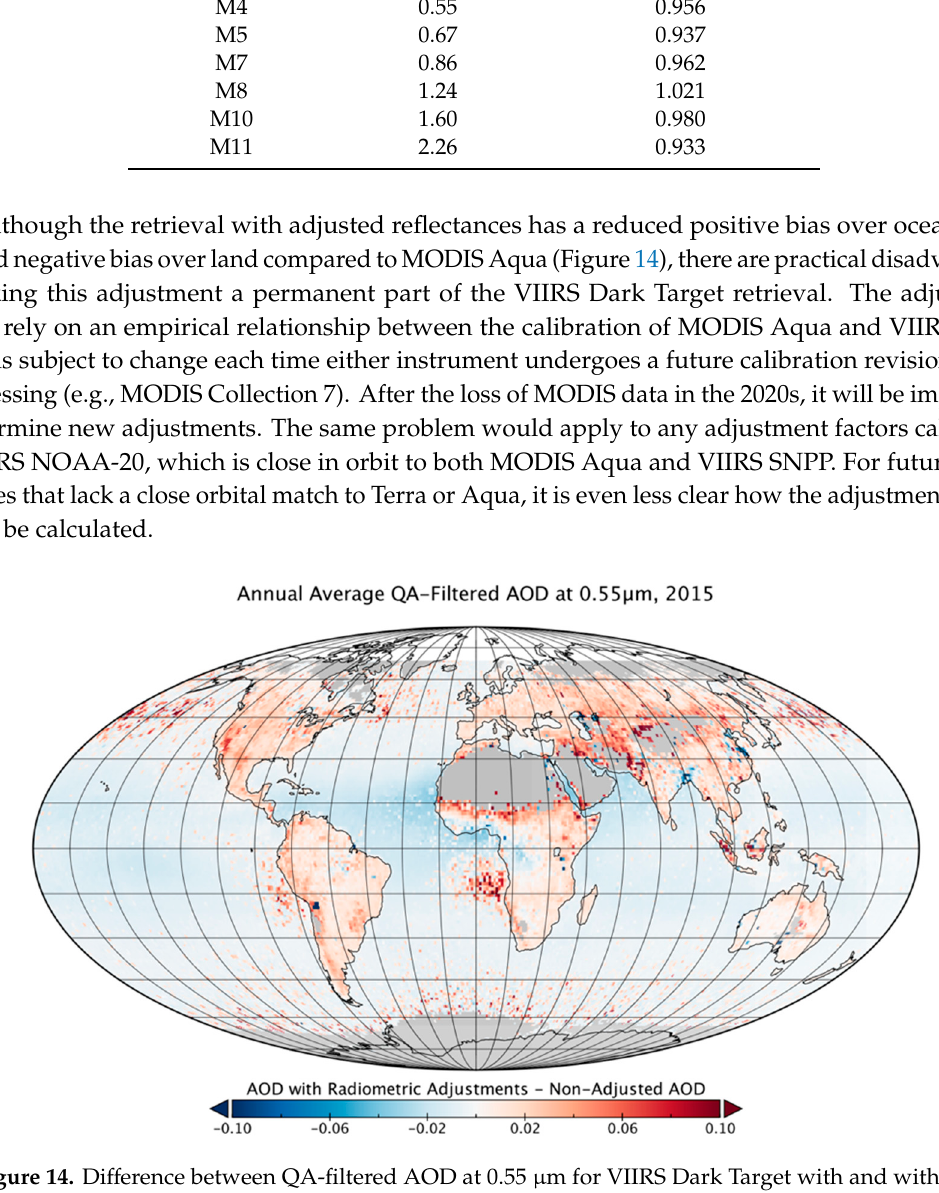
Figure 14. Di ff erence between QA-filtered AOD at 0.55 µ m for VIIRS Dark Target with and without Figure 14. Difference between QA-filtered AOD at 0.55 μ m for VIIRS Dark Target with and without adjustment factors applied to the input reflectances. The global mean di ff erence is + adjustment factors applied to the input reflectances. The global mean difference is +0.0.